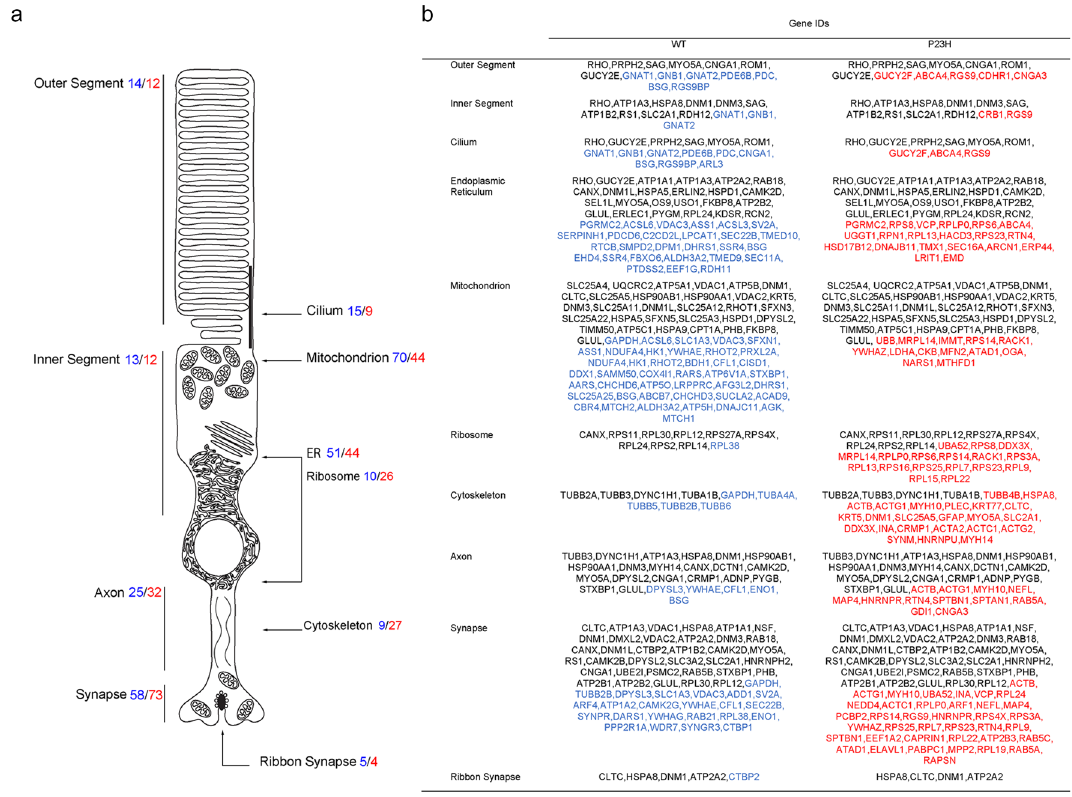
Figure 5. P23H rhodopsin interactome shows enrichment of proteins from synaptic, axonal, cytoskeletal, and ribosome compartments. ( a ) Graphic shows several subcellular structures in the rod photoreceptor